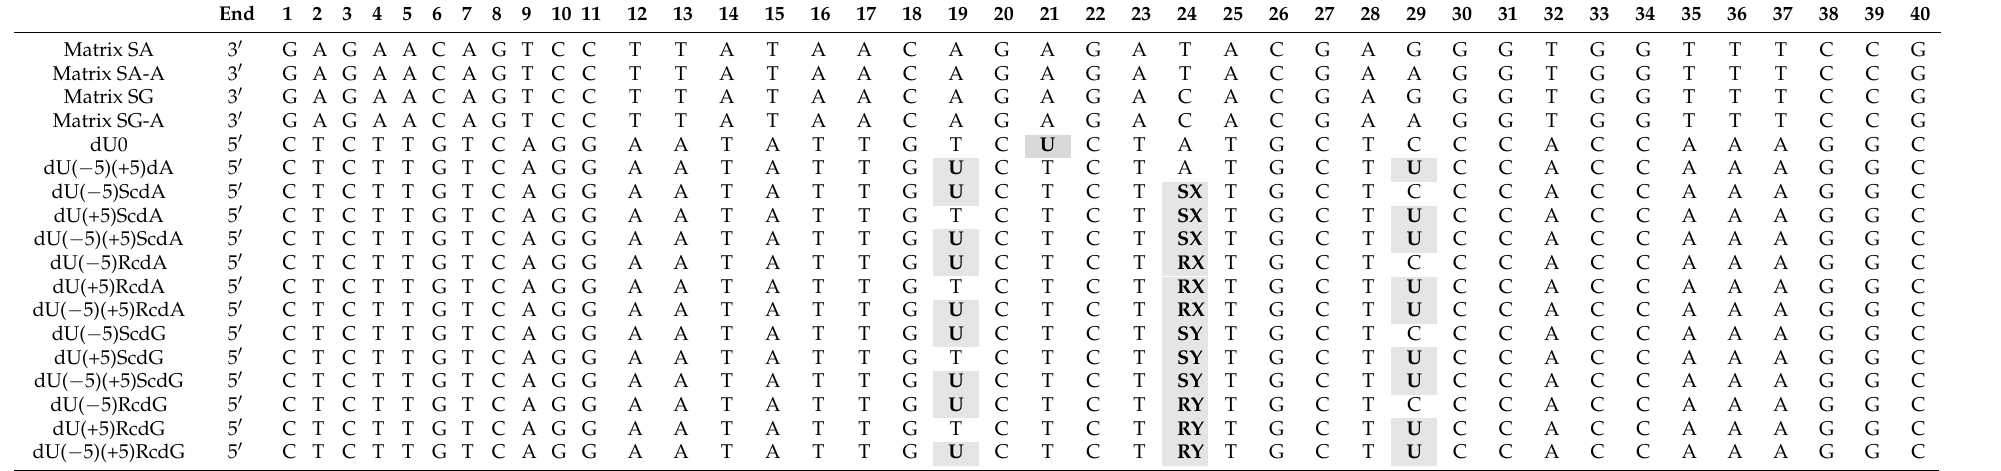
Abbreviations mean the following: SX—(5 (cid:48) S) − 5 (cid:48) ,8-cyclo-2 (cid:48) -deoxyadenosine; RX—(5 (cid:48) R) − 5 (cid:48) ,8-cyclo-2 (cid:48) -deoxyadenosine; SY—(5 (cid:48) S) − 5 (cid:48) ,8-cyclo-2 (cid:48) -deoxyguanosine; RY—(5 (cid:48) R) − 5 (cid:48) ,8-cyclo-2 (cid:48)